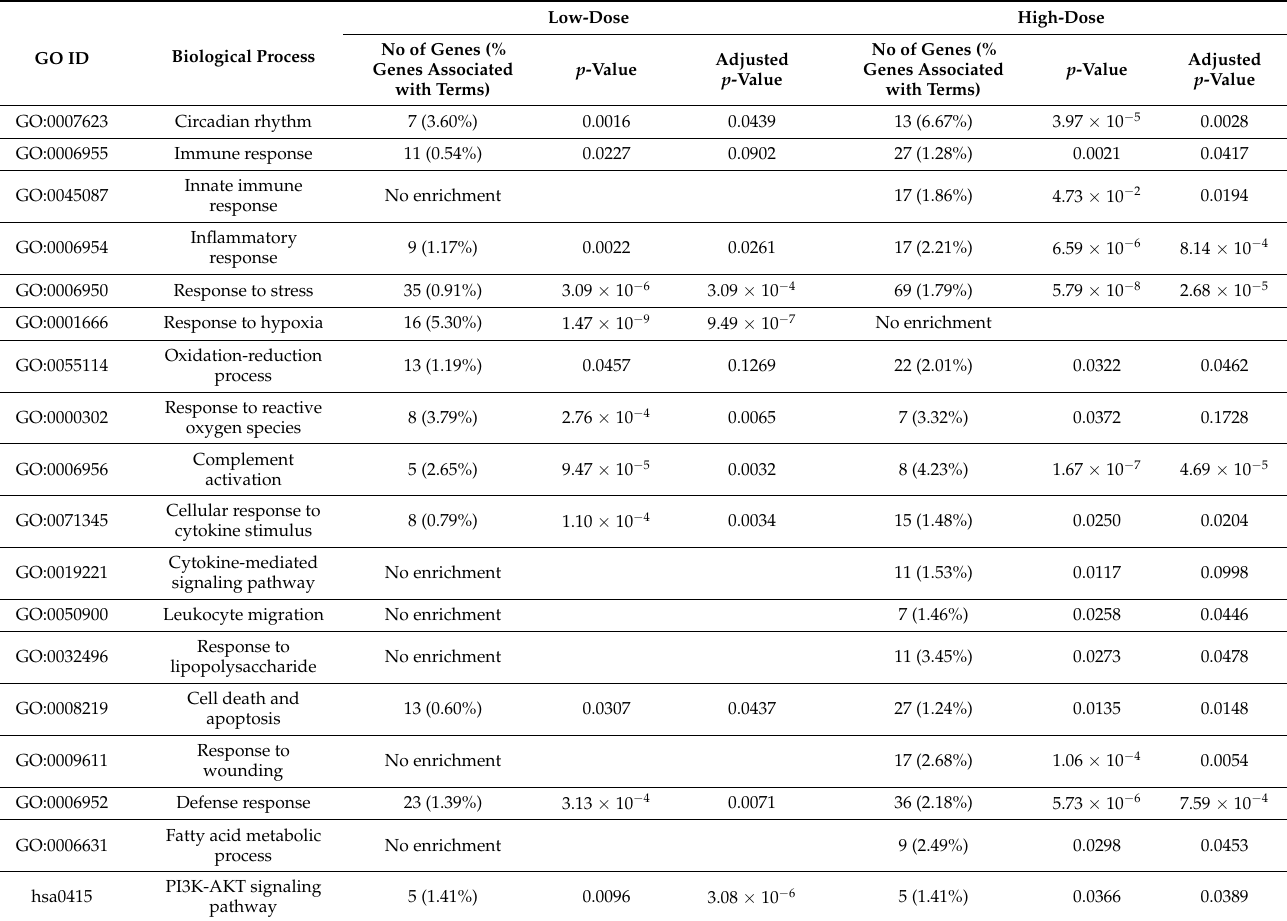
Table 4. Gene ontology enrichment of kidney-related DEGs after diclofenac treatment. Gene ontolo- gies were analyzed with the GeneXplain and ClueGO databases; significantly enriched biological processes were considered at a p -value < 0.05. The percentage of genes associated with biological terms and pathways were calculated with the AmiGO 2 database (http://amigo.geneontology.org/ amigo/landing, accessed on 4 January 2023) and KEGG repository data